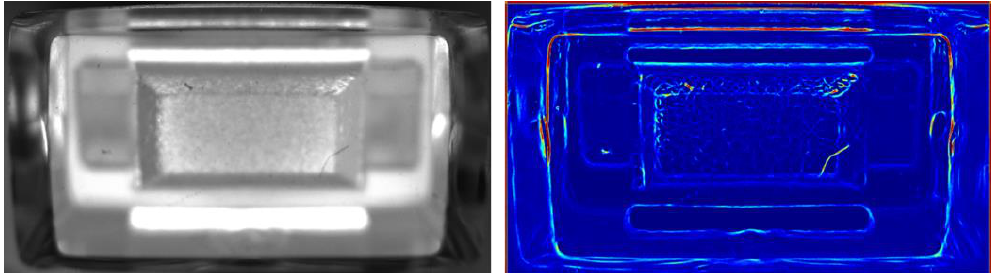
Figure 3. Registered image of an illuminant component ( left side) and the response of the Frangi filter ( right side).